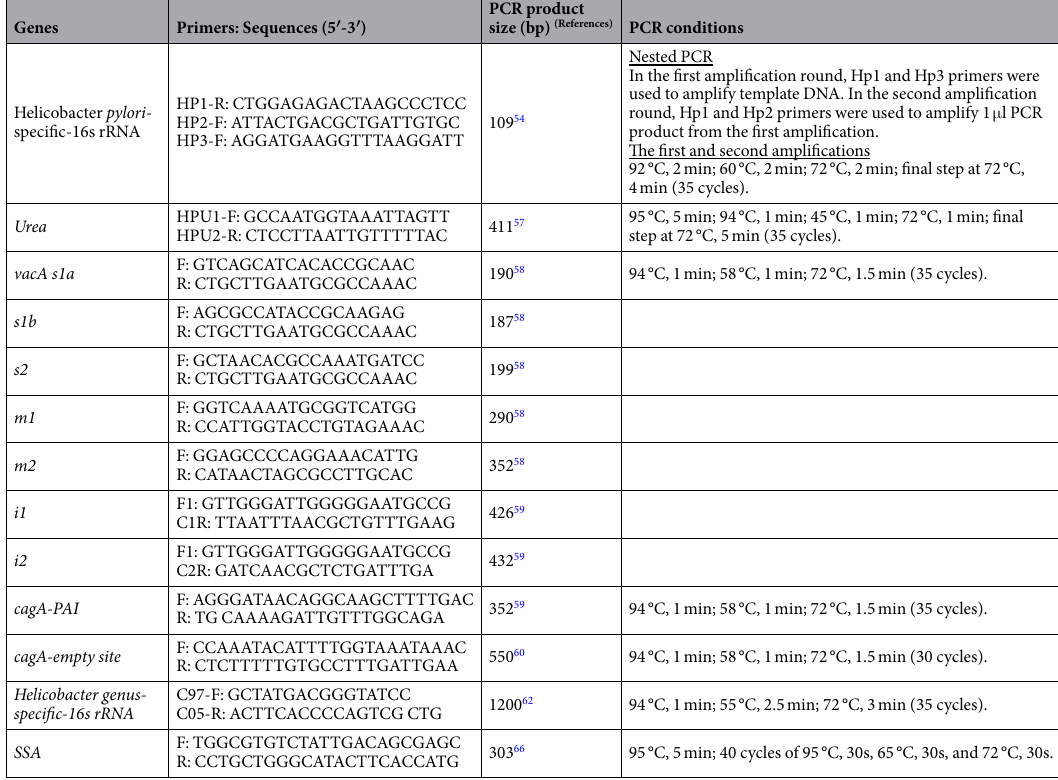
Table 1. Sequences of the primers used in PCR and the amplification conditions.